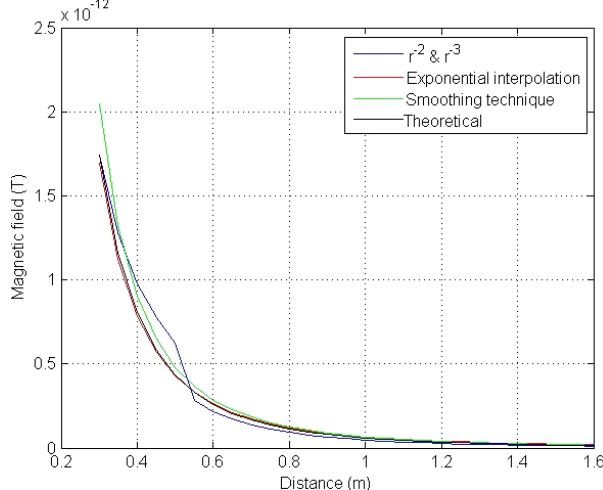
Figure 7. Magnetic field’s prediction with respect to the distance with fixed magnetometers’ locations at 50 and 110cm, using several techniques.